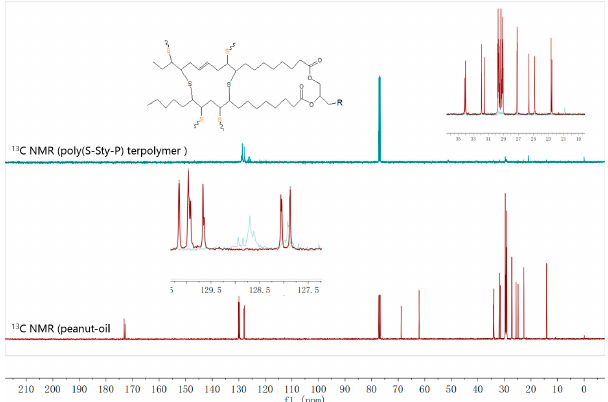
Figure 6. 13 C NMR characterization of poly(S-Sty-P) terpolymer and intramolecular crosslinks.